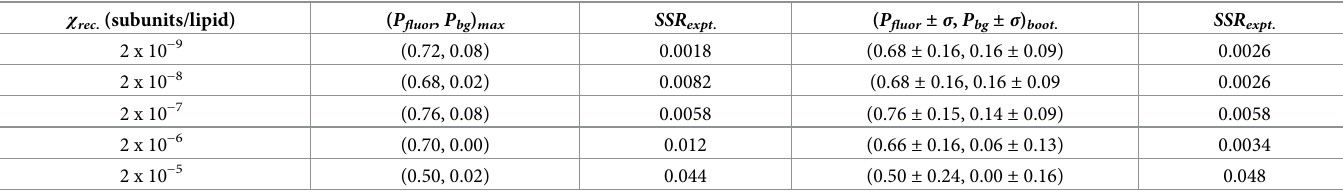
Table 2. Fitted vs. experimental parameters for RCLC sample 1. χ rec . (subunits/lipid) ( P fluor , P bg ) max SSR expt . ( P fluor ± σ , P bg ± σ ) boot . SSR expt